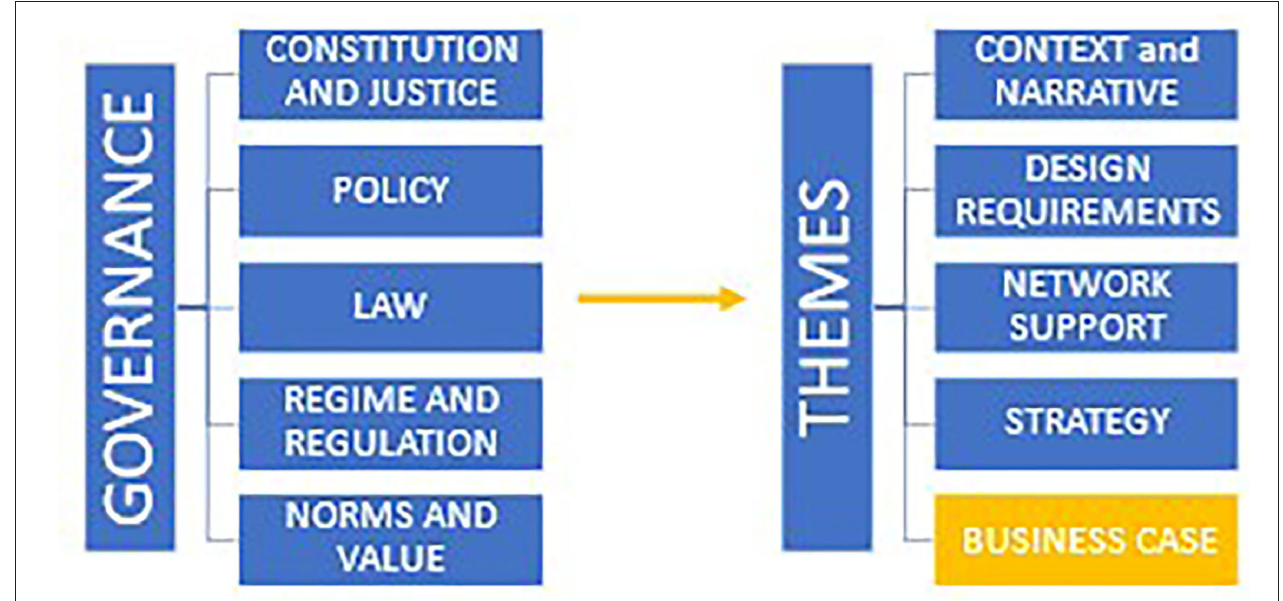
FIGURE 4 | Governance to themes (via